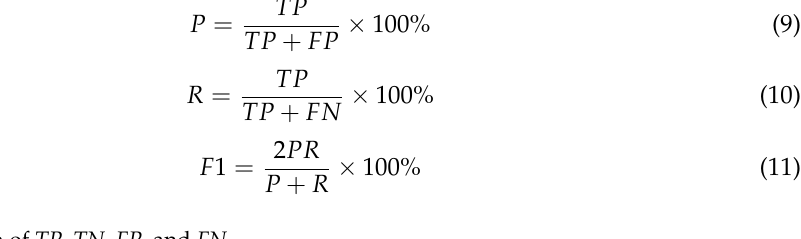
Table 6. Definition of TP , TN , FP , and FN .